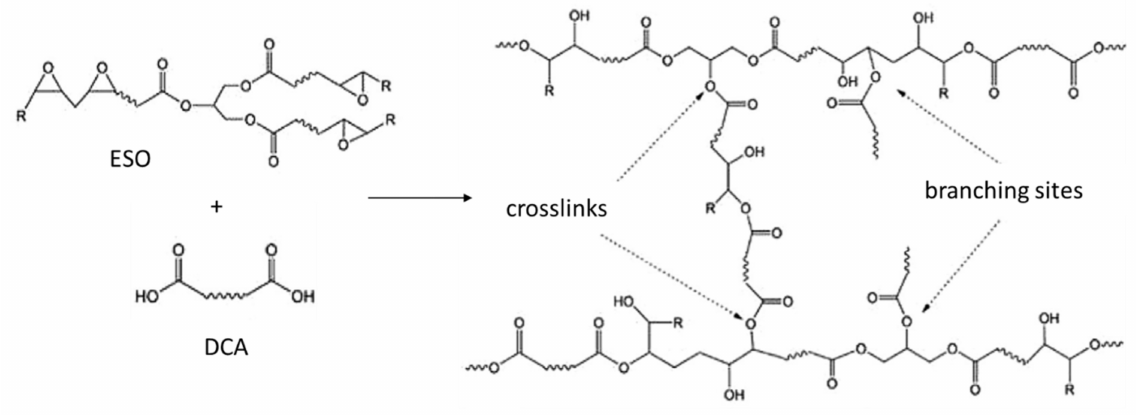
Figure 3. Scheme regarding the reaction between an epoxidized oil (EO) and DCA, resulting in